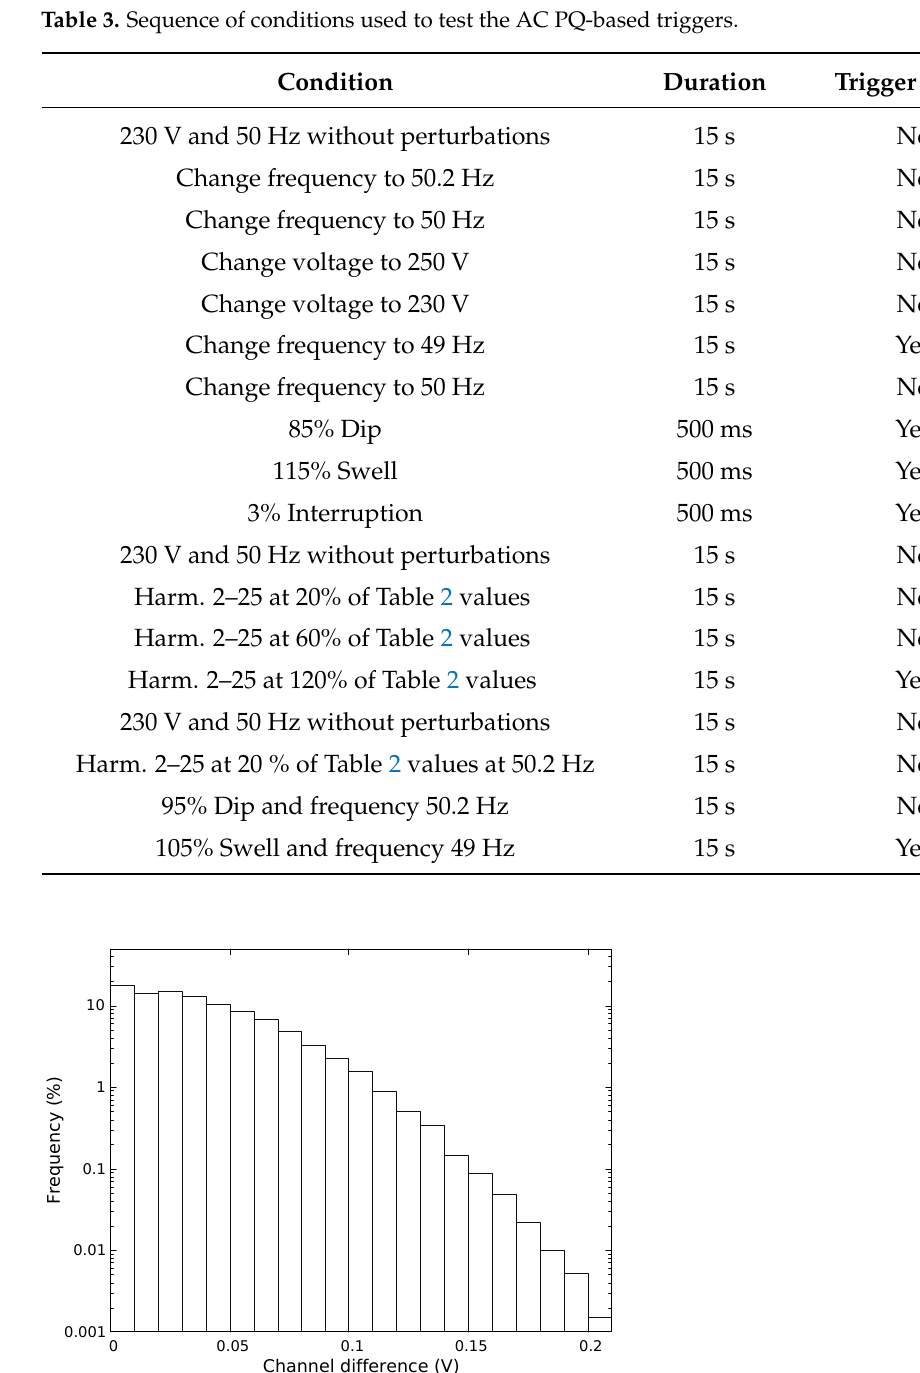
Figure 6. Voltage difference (absolute value) between high and low sampling frequency